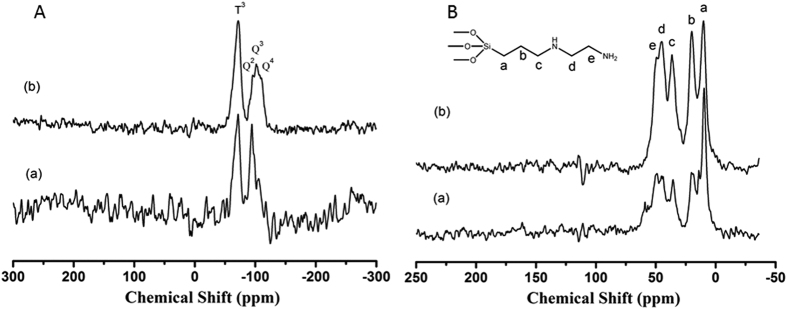
Solid state MAS NMR (A) 29Si and (B) 13C of SAPO-37-DAS-0.16 (a) as-prepared and (b) extracted material.